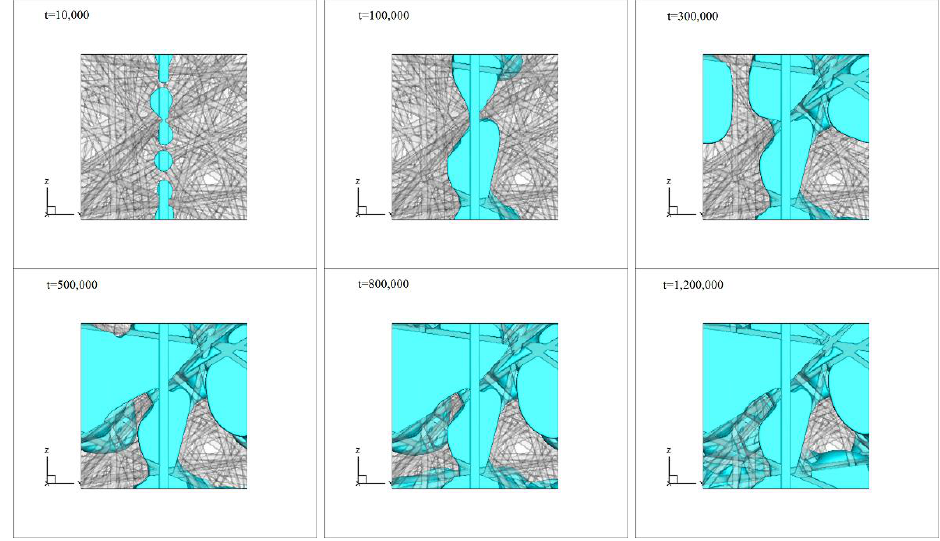
Figure 4. Bottom view of the liquid water distribution in the computational domain.